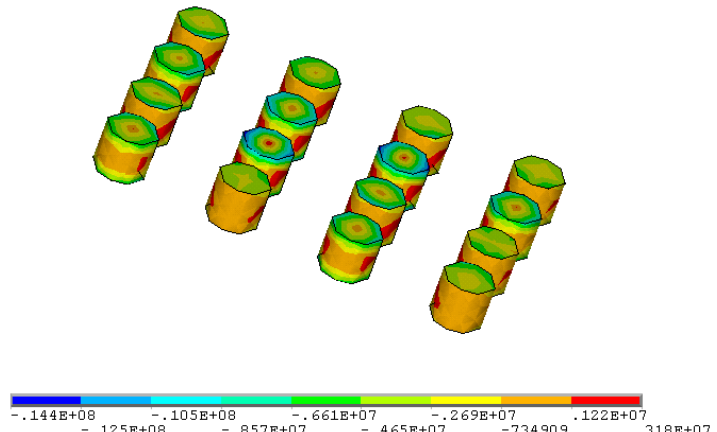
(parameters of scheme 4: stope height 3.5 m, pillar diameter 2 m, pillar spacing 5 m, pillar row spac-